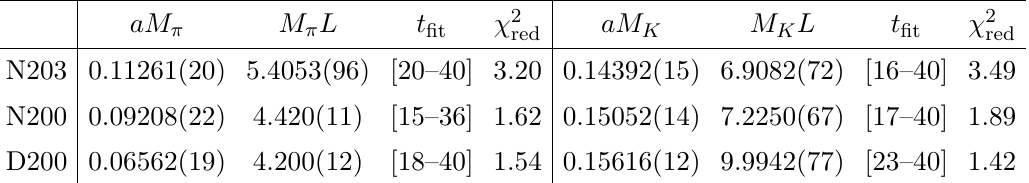
for N203 is discussed in the red